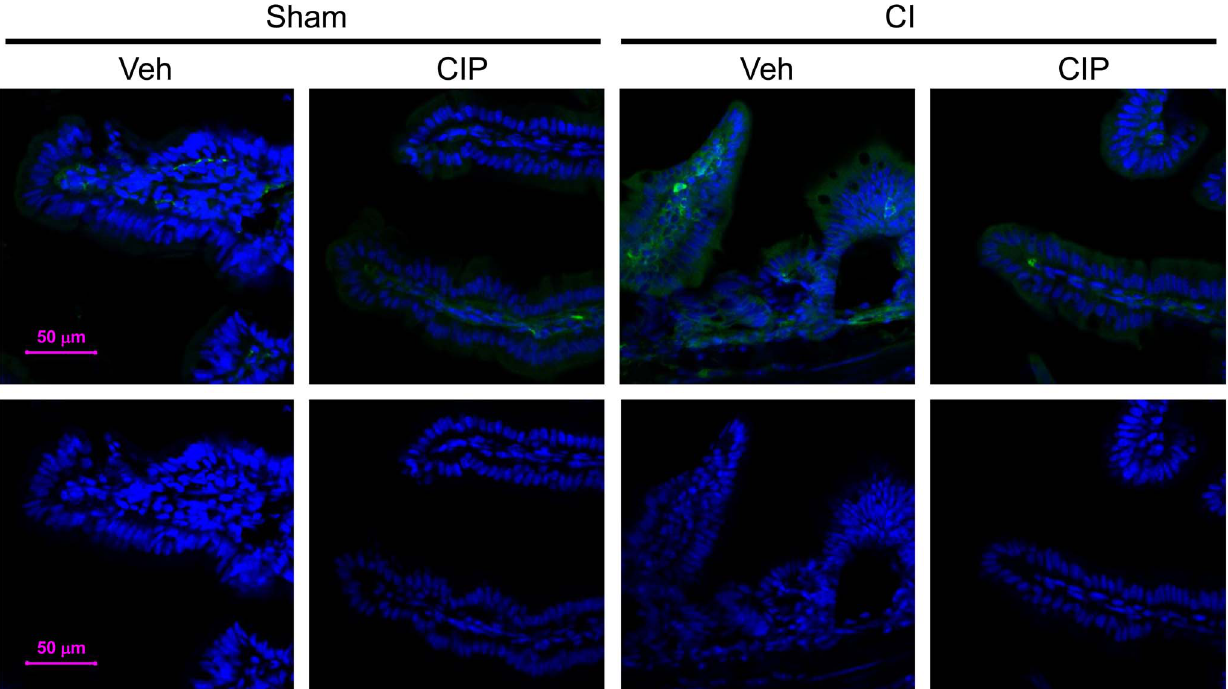
Figure 8. CIP inhibited the CI-induced increase in RelA expression after CI. On day 10 after CI, ileal samples were collected from surviving mice and prepared for immunofluorescent staining on frozen sections. RelA expression was detected (green) and presented with nucleus (blue). Representative pictures are shown with their fluorescence intensities for green signals (bottom). n=4 2 5 per group. CI: combined injury; CIP: ciprofloxacin; Veh: vehicle.